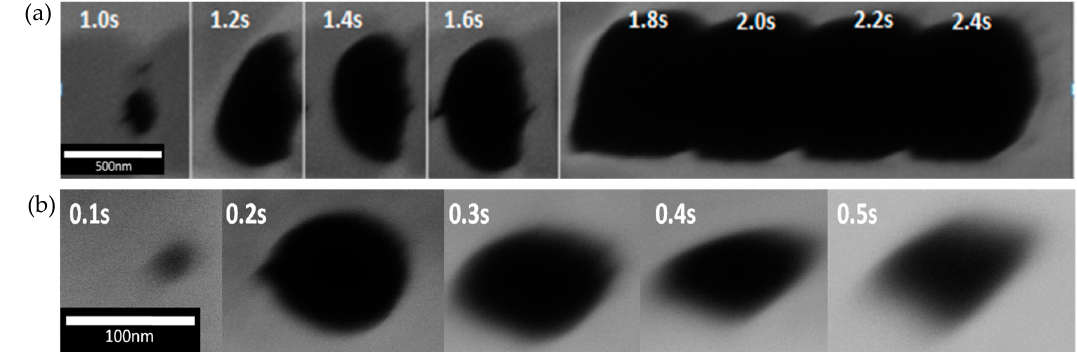
Figure 5. ( a ) the changes of hole size and shape with milling time from 1.0 to 2.4 s, ( b ) the changes of hole size and shape with milling time from 0.1 to 0.5 s.